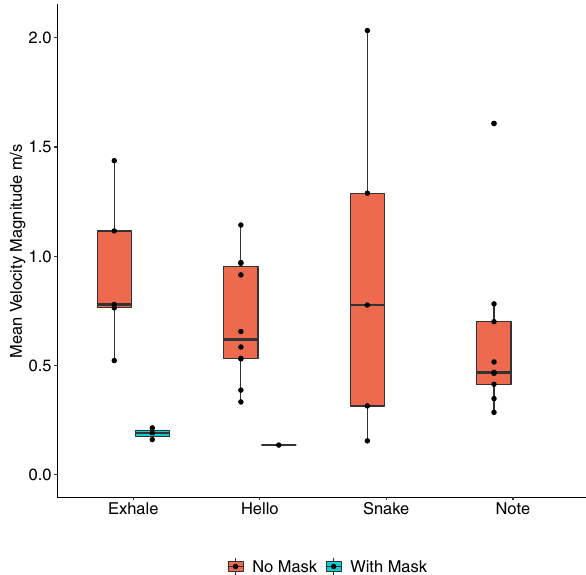
Figure 3. Boxplot with individual data points for mean velocity magnitude (MVM) across different vocal tasks. PTV accuracy is dependent on a higher number (100 s) of images containing significant number of particles. For PIV the concentration of droplets must be higher for valid measurements to be attained. Several participants, for some tasks did not produce droplets to a level that satisfies the above conditions, as such no meaningful measurements could be taken. Data are not available for saying ‘snake’ with a mask, singing a note with a mask and singing ‘Happy Birthday’. Figures produced in R software 4.0.4 34 using the ggplot2 package 35 .